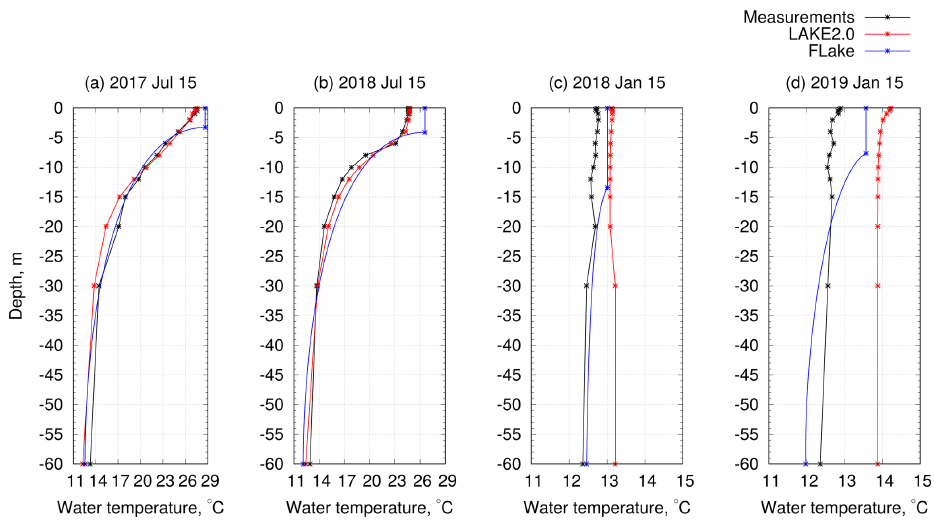
Figure 5. Water temperature profiles for 15 July 2017 (a) , 15 January 2018 (b) , 15 July 2018 (c) , and 15 January 2019 (d) , each at 12:00UTC.